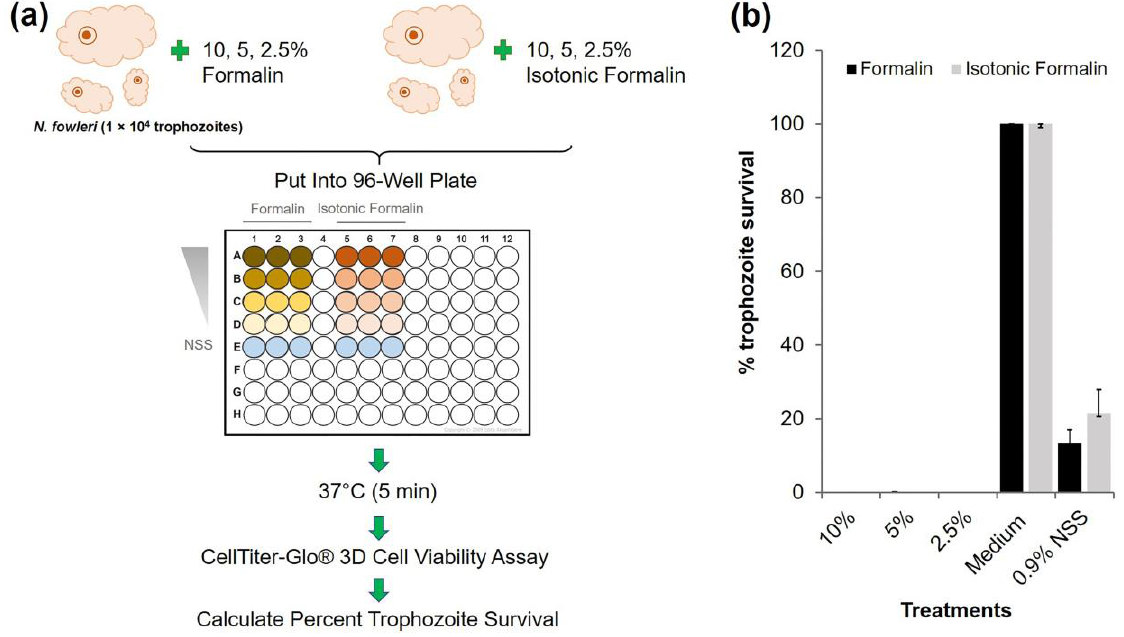
Figure 2. Inactivation activities of formalin and isotonic formalin at different concentrations against Naegleria fowleri : ( a ) Flow diagram of inactivation assay. ( b ) Percent survival of N. fowleri trophozo- ites treated with formalin and isotonic formalin 5 min at 37 °C. The results are shown as the mean ± standard deviation (SD) of a representative of three independent experiments.